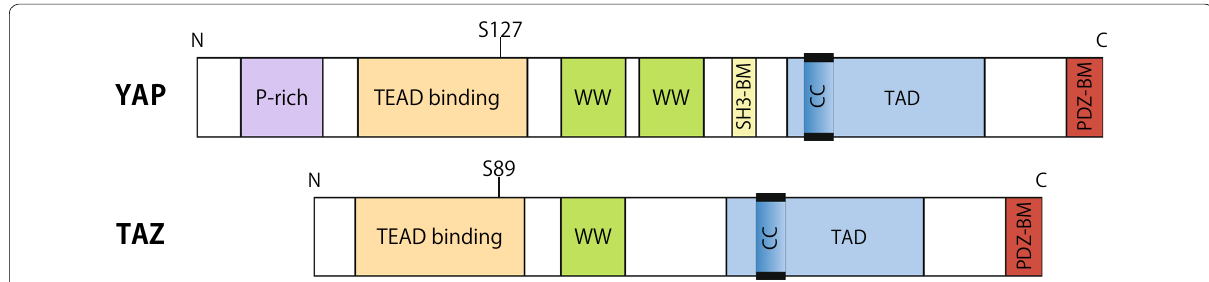
Fig. 1 Domain structures of YAP and TAZ. YAP is a 65-kDa protein containing a proline-rich region (P-rich) in the N-terminal region and a PDZ-binding motif (PDZ-BM) in the C-terminal region that are separated by two WW domains, a TEAD binding domain, a Src homology domain 3 binding motif (SH3-BM), and a coiled–coil domain (CC) within the transactivation domain (TAD). There are 8 isoforms of YAP exist which differ by loss of one WW domain and alterations in TAD. TAZ, a 43-kDa paralog of YAP, has similar domain organization but lacks the proline-rich region, the SH3-BM and one WW domain. YAP S127 and TAZ S89 are the main phosphorylation targets of LATS1/2. Upon phosphorylation YAP/TAZ binds with 14-3-3 and thus are sequestered in the